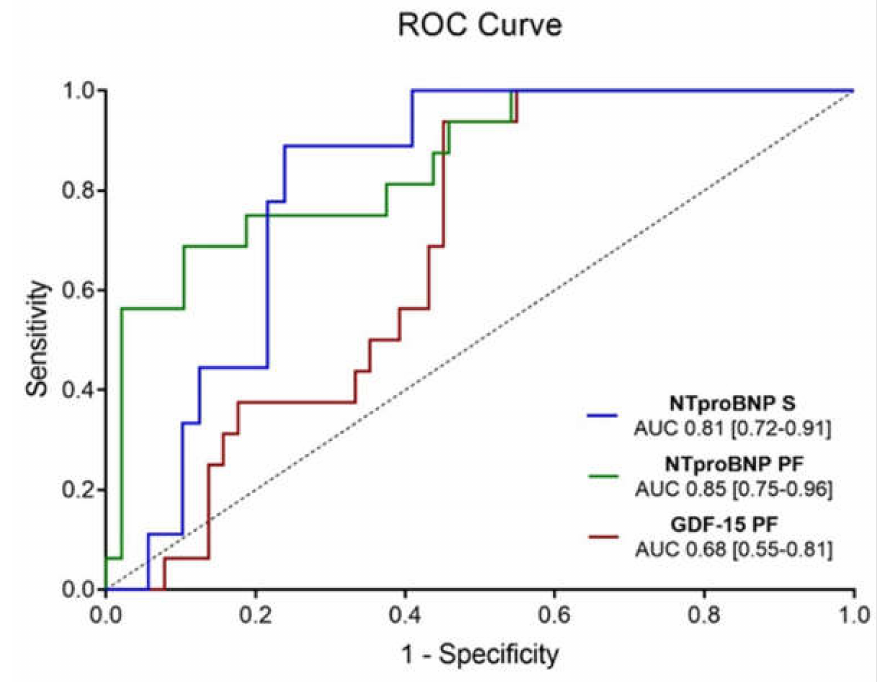
Figure 2. AUROC Curves of pericardial fluid and serum NT-pro-BNP and pericardial fluid